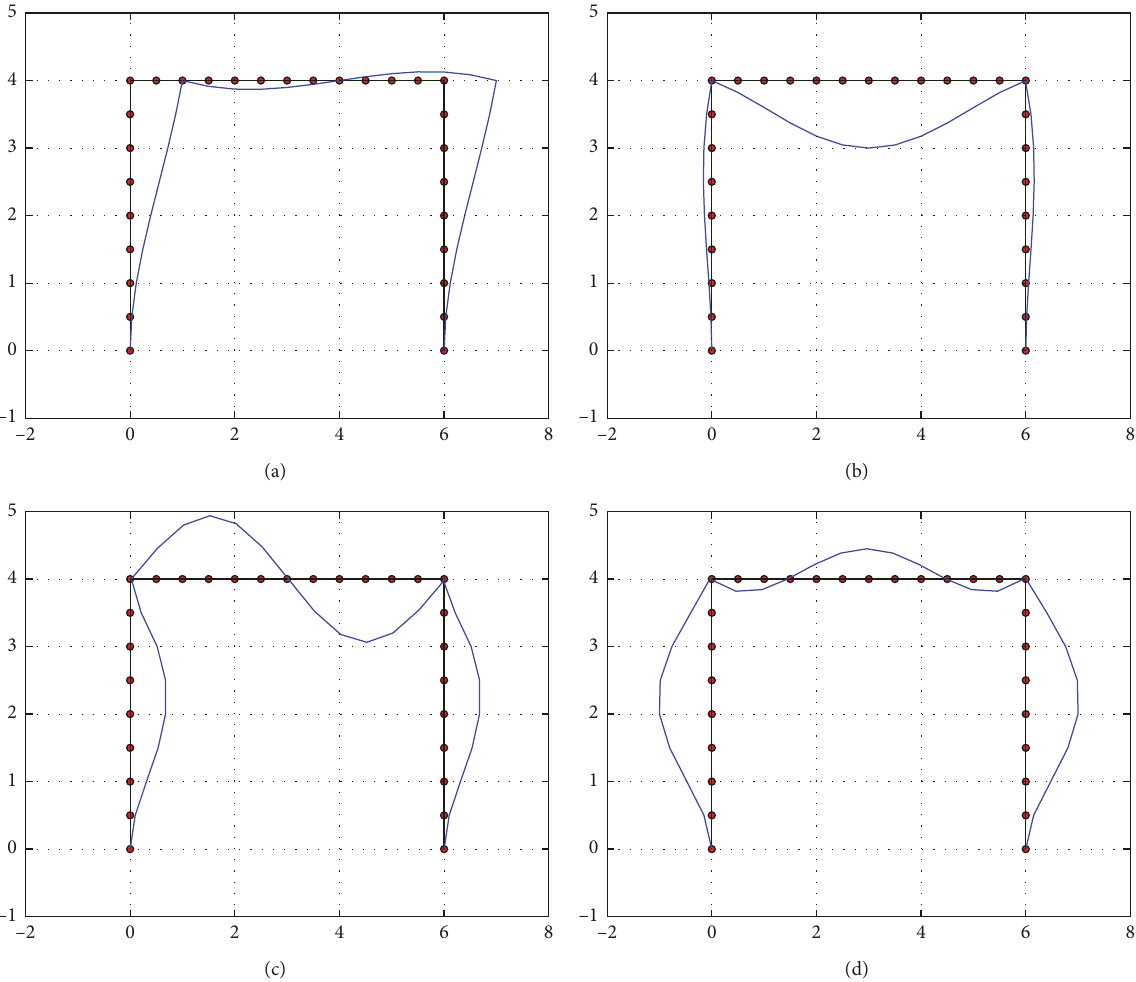
Figure 10: Frame example: first four eigenmodes of the undamaged structure. (a) Eigenmode 1 ( T 0.021s), and (d) eigenmode 4 ( T 4 (c) eigenmode 3 ( T 3 (cid:31)